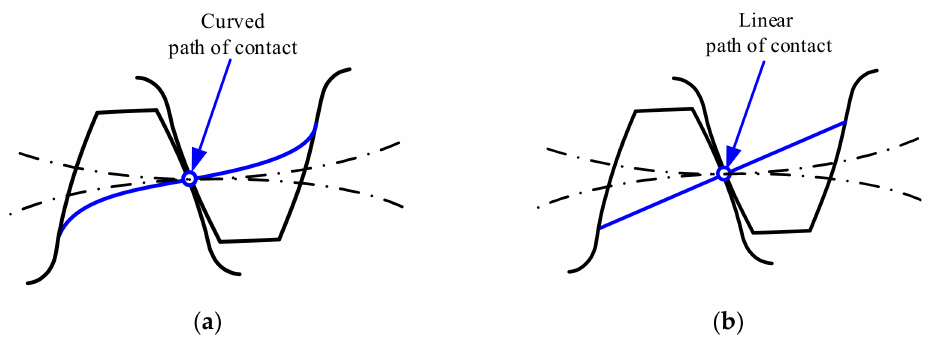
Figure 1. The novel non-involute gears and involute gears. ( a ) Novel non-involute gears; ( b ) Invo- lute